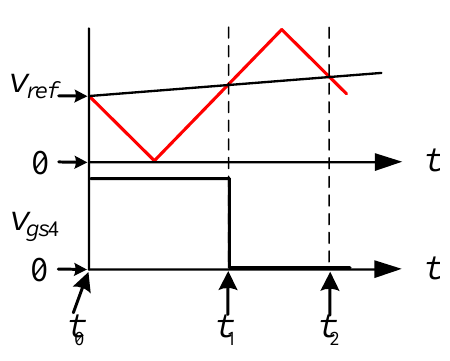
Figure 3. Gate signal of S 4 .